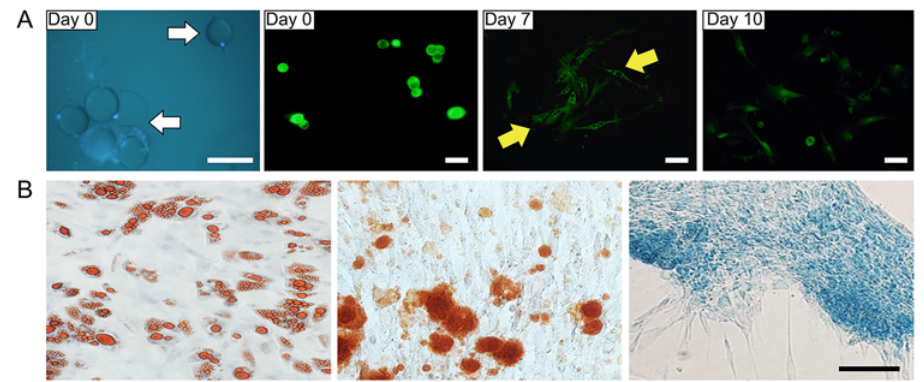
Fig 6. Morphology change of GFP+ adipocytes during dedifferention. A: monolocular mature adipocytes (white arrow) with GFP signal at day 0. After 7 days ceiling culture, cells with multilocular lipid droplets were observed (yellow arrow). 10 days later, the cells had a fibroblast-like morphology with no visible fat droplets. Scale bar = 100 μ m. B: The adipogenic (left), osteogenic (middle) and chondrogenic (right) differentiation of DFAT cells. Scale bar = 25 μ m.